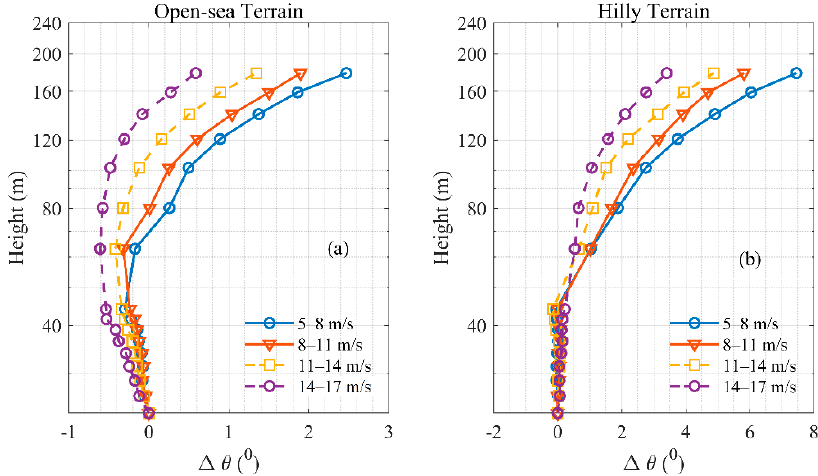
Figure 6. Composite wind veer profiles associated with different upstream terrains. ( a ) for open-sea terrain, i.e., 60° to 240° ( b ) for hilly terrain, i.e., 0° to 50° and 290° to 360°.